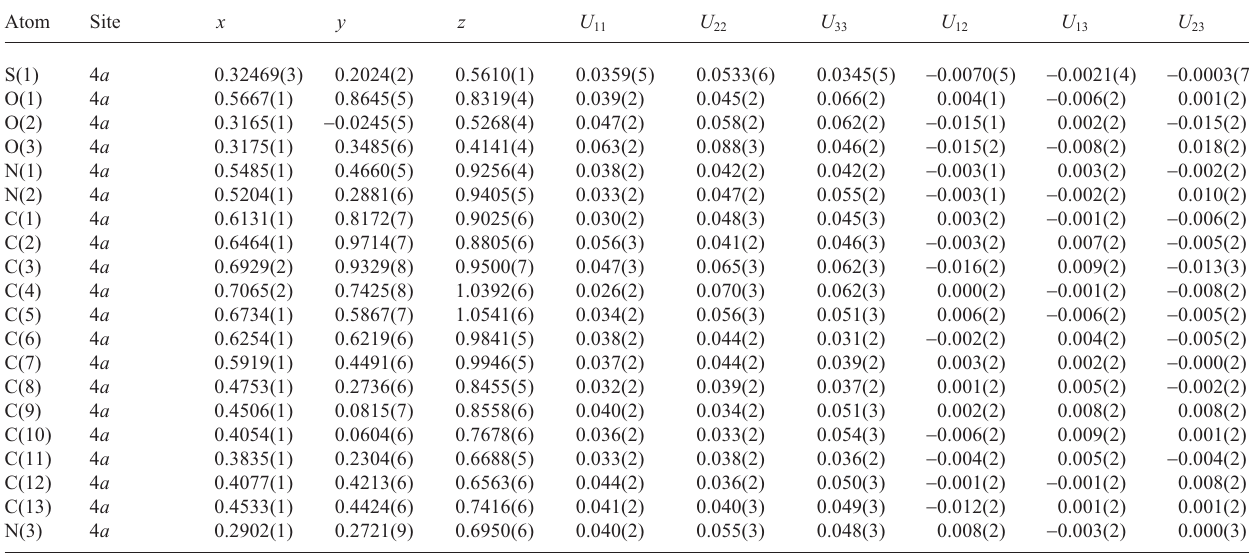
Table 3. Atomic coordinates and displacement parameters (in Å 2 )